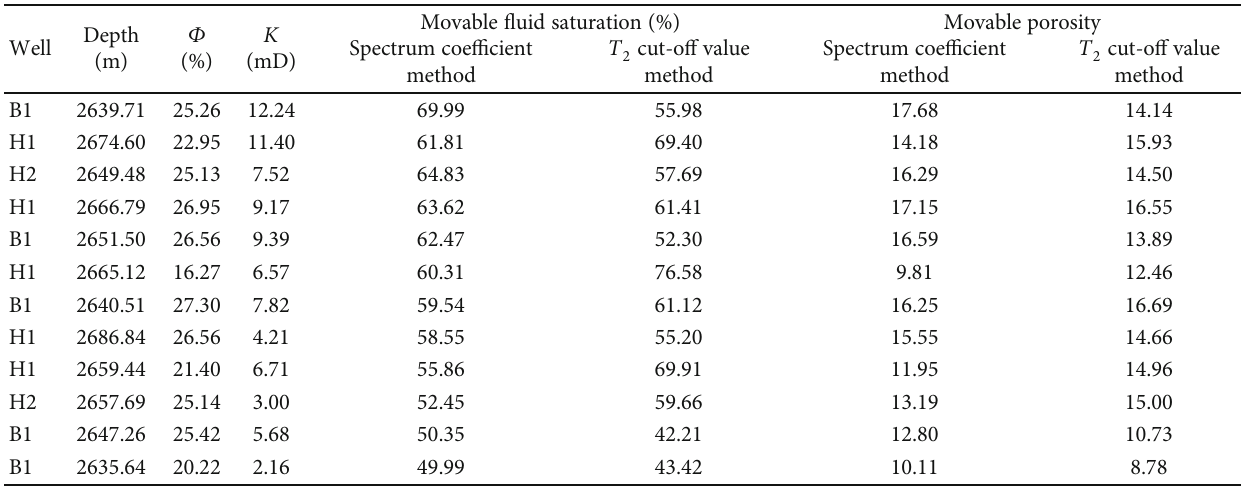
Table 2: NMR data of the K formation